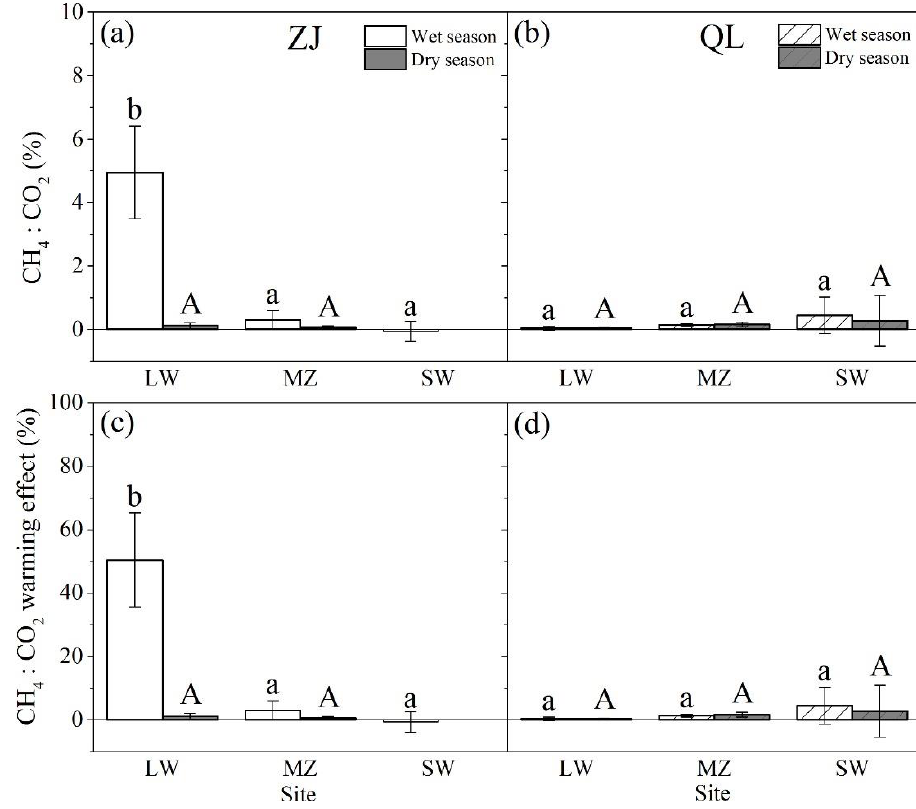
Figure 4. CH 4 :CO 2 effluxes ratio and CH 4 :CO 2 warming effect ratio from ZJ and QL mangrove wetlands. ( a – b ) Comparison of CH 4 :CO 2 effluxes ratio among three tidal positions during wet and dry seasons at ZJ and QL sites. ( c – d ) Comparison of CH 4 :CO 2 warming effect ratio among three tidal